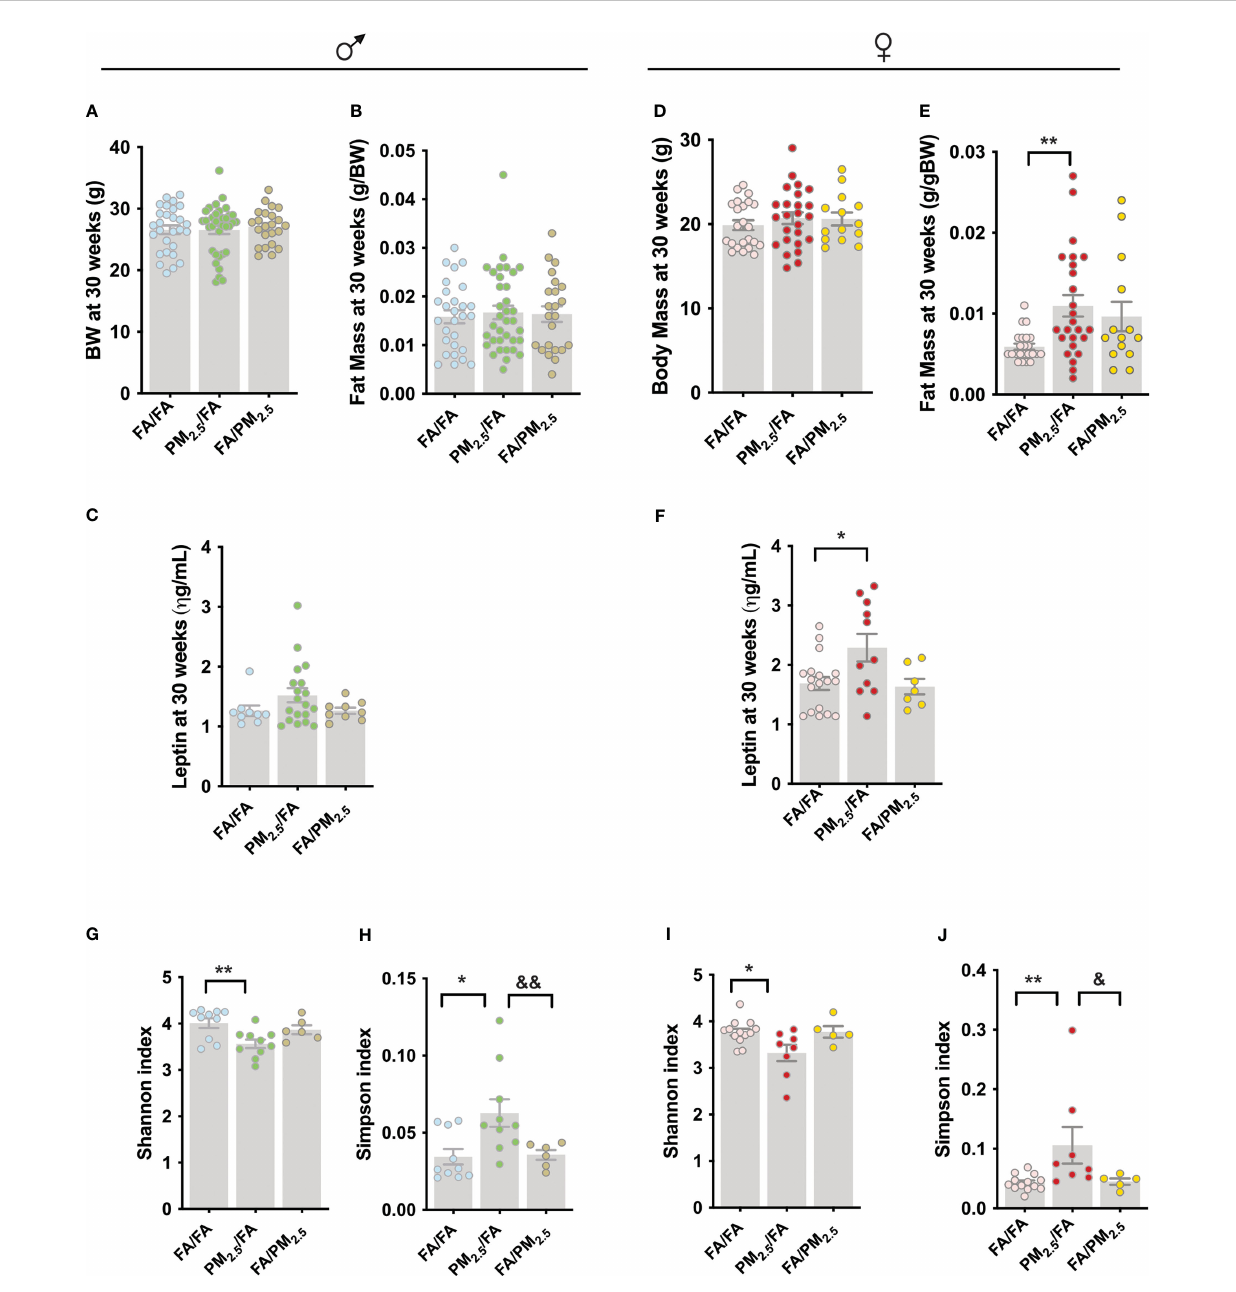
FIGURE 3 Maternal PM 2.5 exposure alters alpha diversity and gut microbiota composition independent of gender. (A) Male body weight (g); (B) Male fat mass (g/gBW), n=23-35 and (C) Male fasting serum leptin level ( h g/mL), n=9-19. (D) Female body weight (g); (E) Female fat mass (g/gBW), n=14-26 and (F) Female fasting serum leptin level ( h g/mL), n=14-25. Alpha diversity was estimated by the (G) (male): Shannon index and (H) (male): Simpson index (n=6-10). Alpha diversity was estimated by the (I) (female): Shannon index and (J) (female): Simpson index i (n=5-13). (A-C) males and (D-F) females from offspring whose mothers were exposed to PM 2.5 during pregnancy (PM 2.5 /FA) or lactation (FA/PM 2.5 ) and fi ltered air during pregnancy and lactation (FA/FA) as a control group. All mice were 30 weeks of age. Data were expressed as the mean ± SEM. One-way ANOVA was used for the statistical analysis. We used Bonferroni as a post hoc test and a signi fi cance of P<0.05. p values: **P<0.01; *P<0.05 (PM2.5/FA vs. FA/FA); && P<0.01; & P<0.05